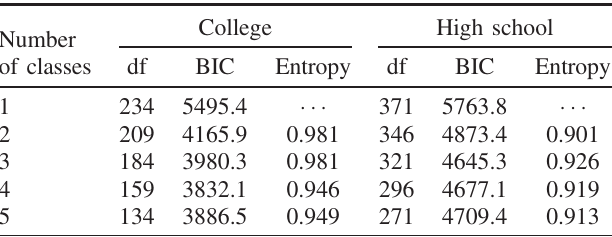
TABLE V. Latent class analysis goodness of fit measures for the college and high school